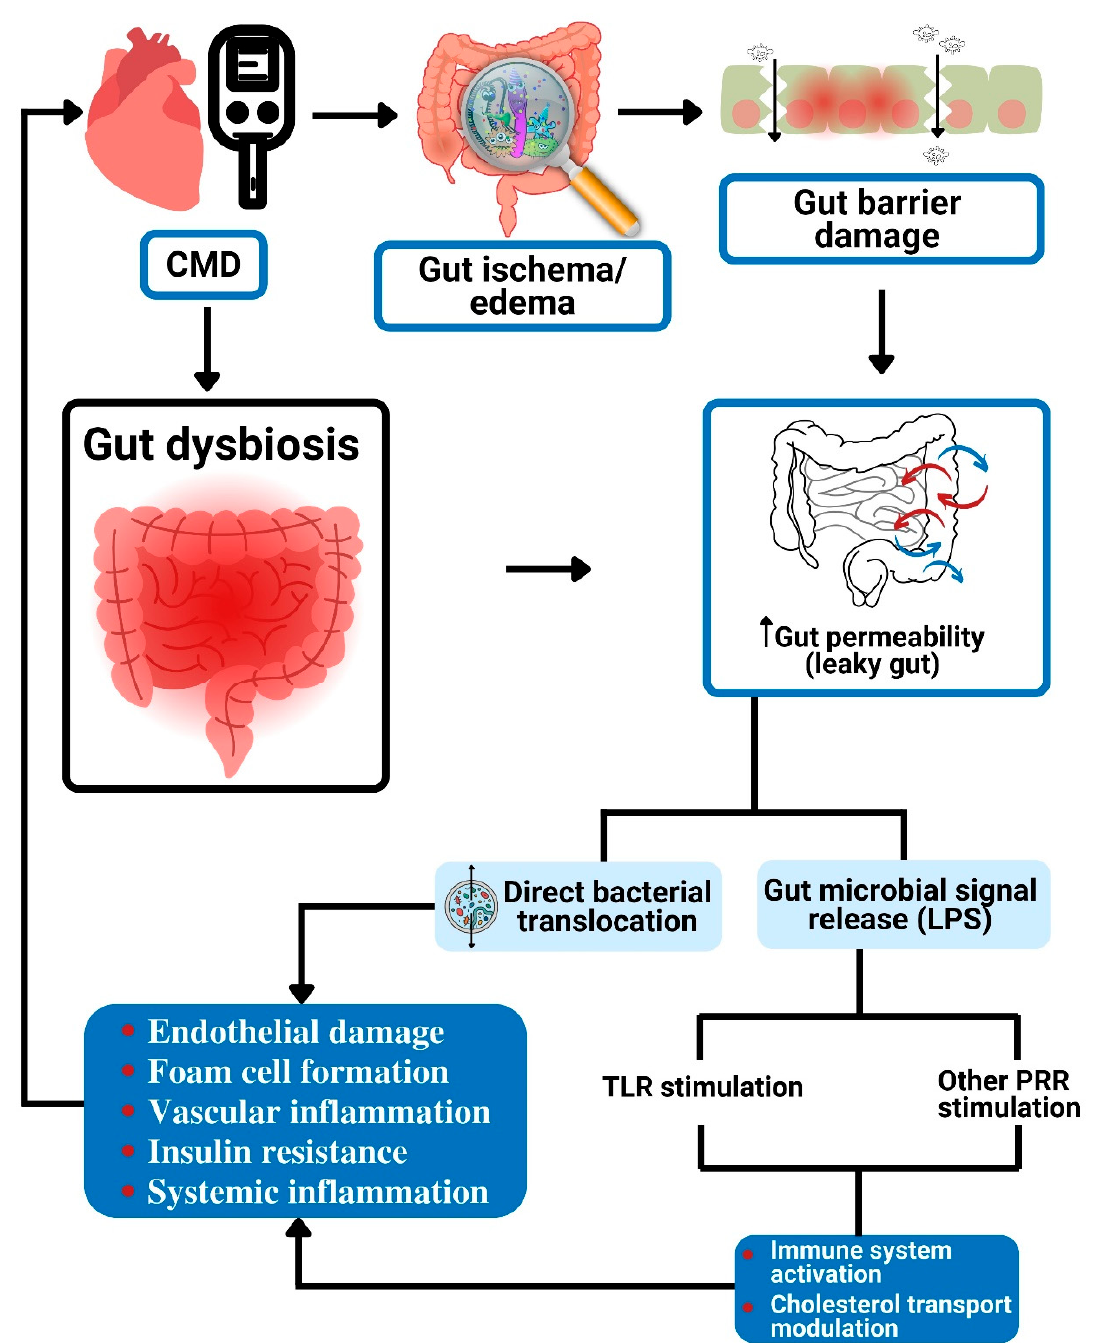
Figure 1. Gut dysbiosis and potential metabolism-independent pathways linked to cardiometabolic diseases. The increased gut permeability effect of gut dysbiosis causes direct bacterial